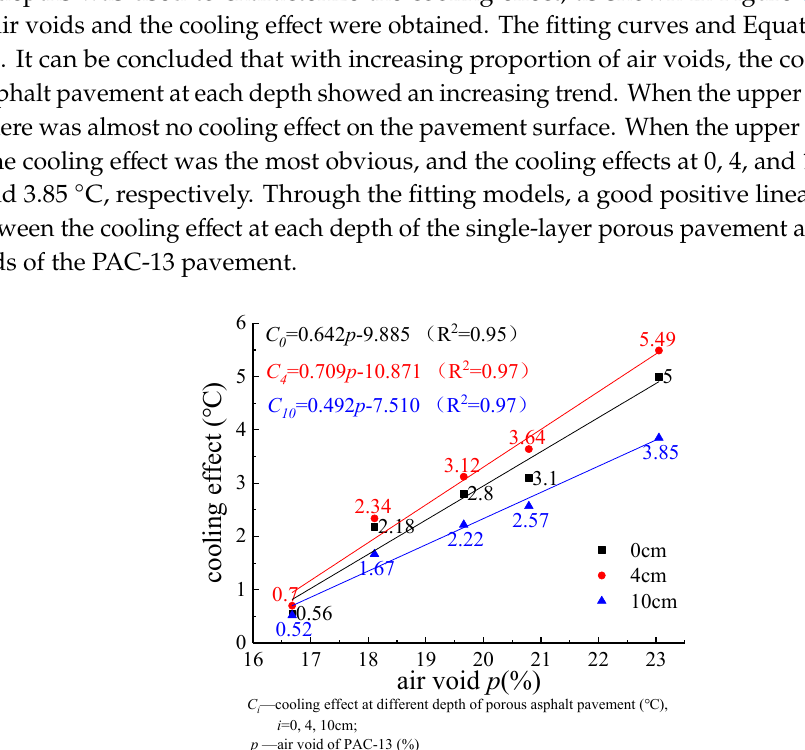
Figure 8. Fitting curves of air void proportion and the cooling effect of PAC pavement.